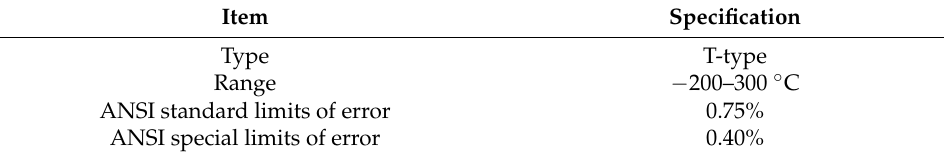
Table 2. Specification of thermocouple.